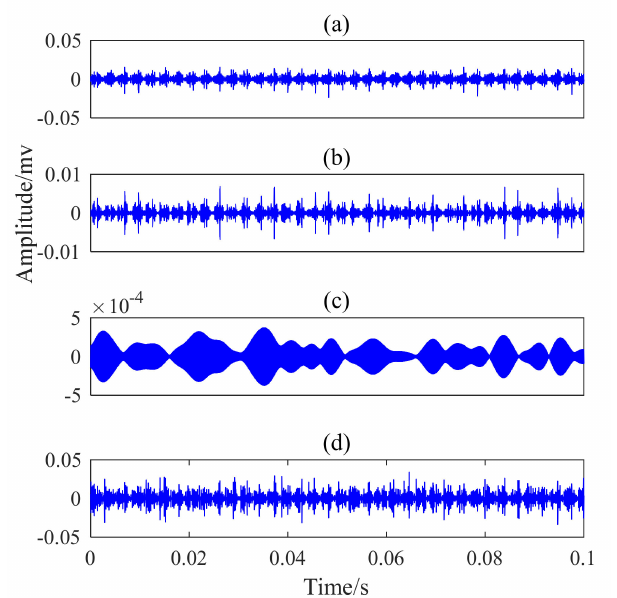
Figure 6. The IMFs of simulation signal obtained by the EWT method: ( a ) IMF1; ( b ) IMF2; ( c ) IMF3; ( d ) IMF4.